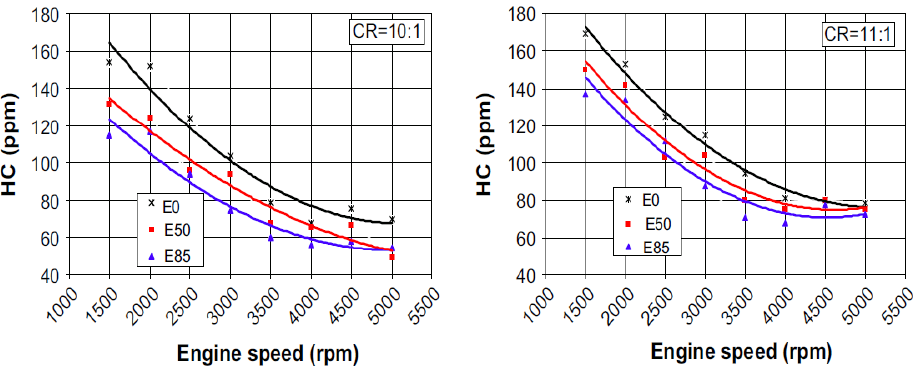
Figure 6. Variation in HC emissions with engine speed and ethanol content in the blends at different compression ratios (CR=10:1 on the left and CR=11:1 on the right): comparison between gasoline (E0), 50% ethanol v / v (E50) and 85% ethanol v / v (E85) [94]. Reproduced with permission from Renewable Energy; published by Elsevier, 2009. License Number: 5094080704915.